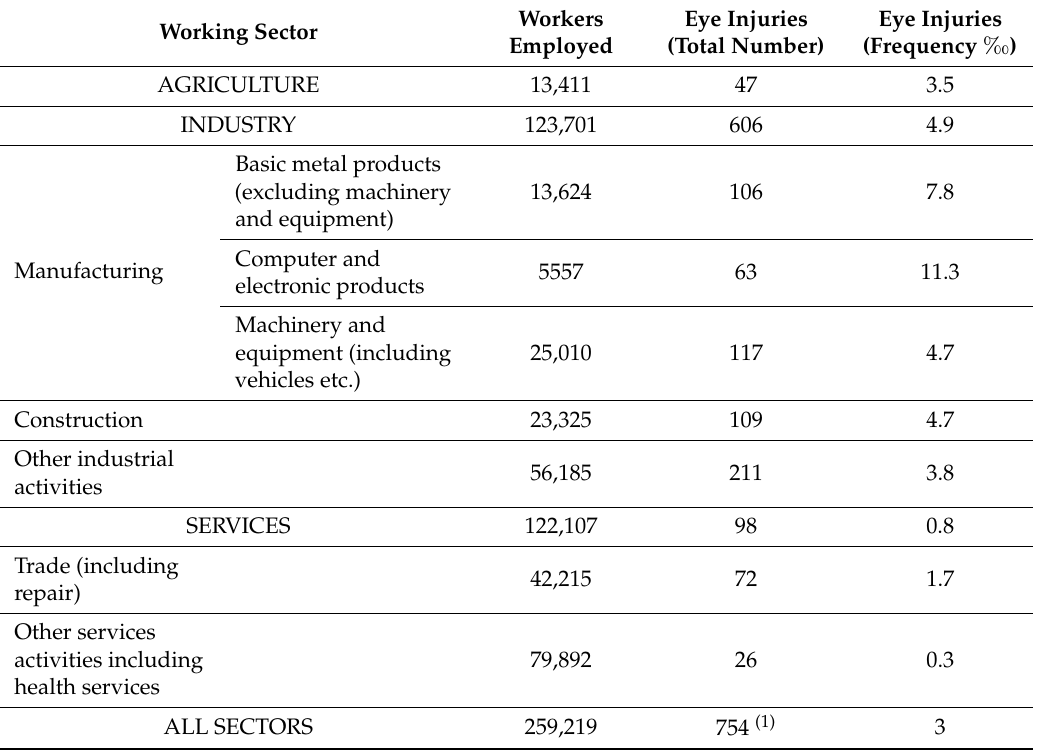
Figure 4. Number of work-related eye injuries in 2014 in the province of Modena in agriculture, industry and the services sectors, according to the month of access to the Ophthalmological Emergency Department (OED). Table 1. The number of workers employed in the province of Modena in 2014 in various working sectors classified according to the “Attività Economiche” (ATECO) classification system, number of occupational eye injuries, and the annual frequency per 1000 workers.